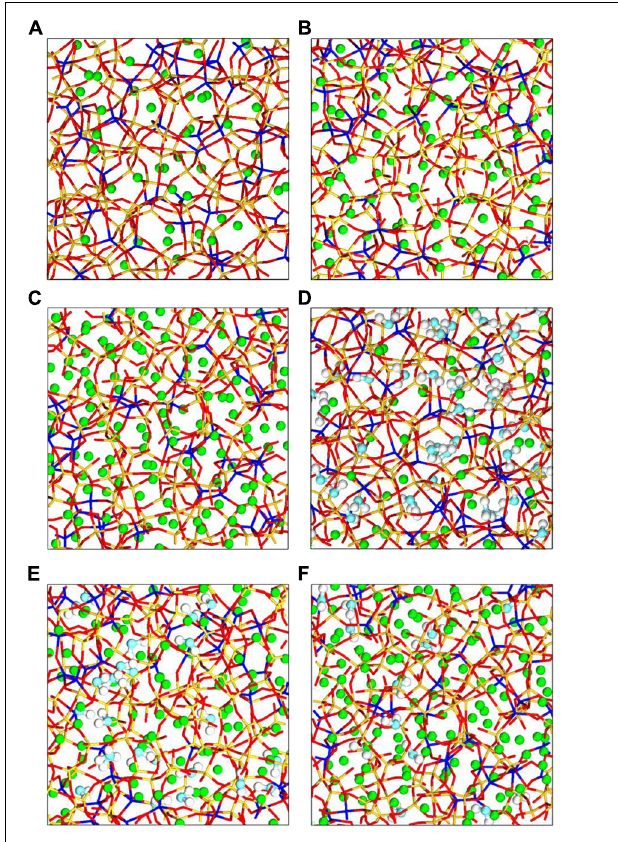
FIGURE 1 | Snapshot of the simulated NAS glass with Na/Al ratio (A) 1.0, (B) 2.0, (C) 3.0. The red (O atom) and yellow (Si atom) line represents the Si-O bond, the red and blue (Al atom) line represents the Al-O bond, and the green ball is sodium. Such markings are adopted in all of the following figures and the molecular structure of the NASH gel model with Na/Al ratio (D) 1.0, (E) 2.0, (F) 3.0. The light blue ball represents the O atom in water molecular or hydroxyl, the white ball represents the H atom. The balls have the same meaning in all following figures.